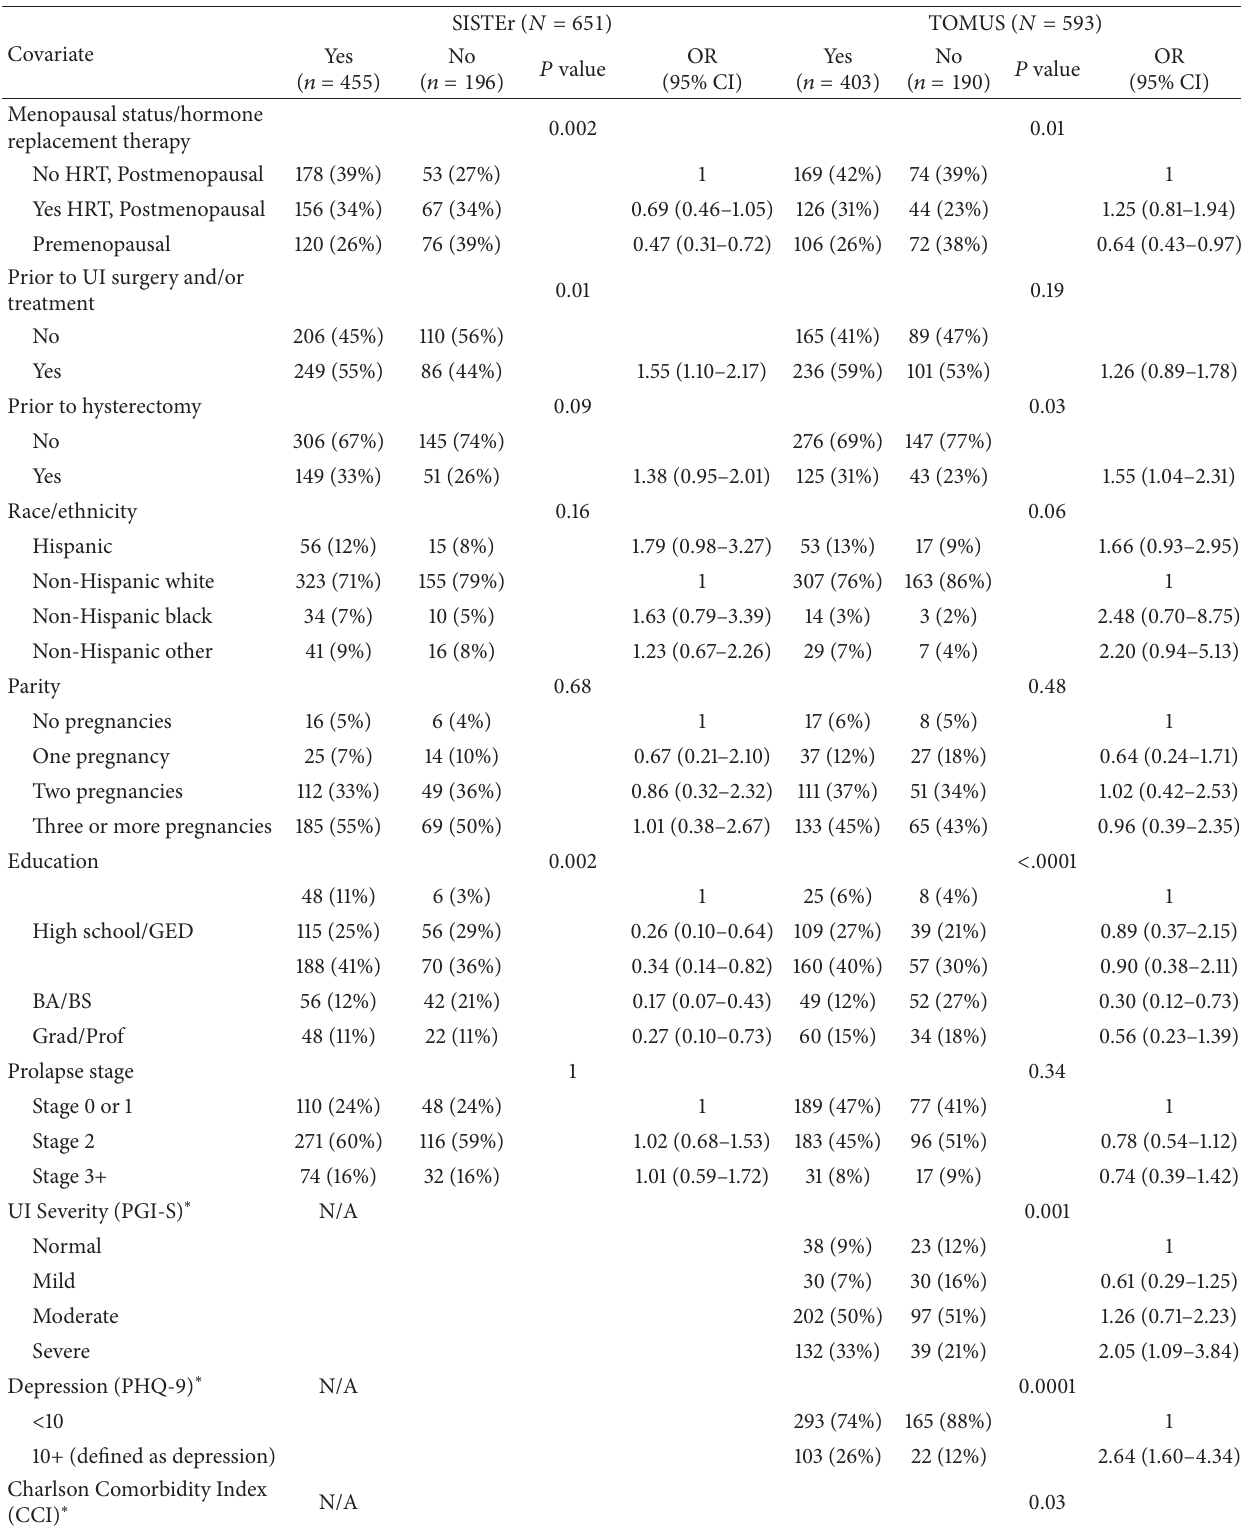
Table 1: Descriptive statistics by UUI status and results of separate bivariate logistic regression models with outcome of those having UUI. Results reported separately for the SISTEr and TOMUS